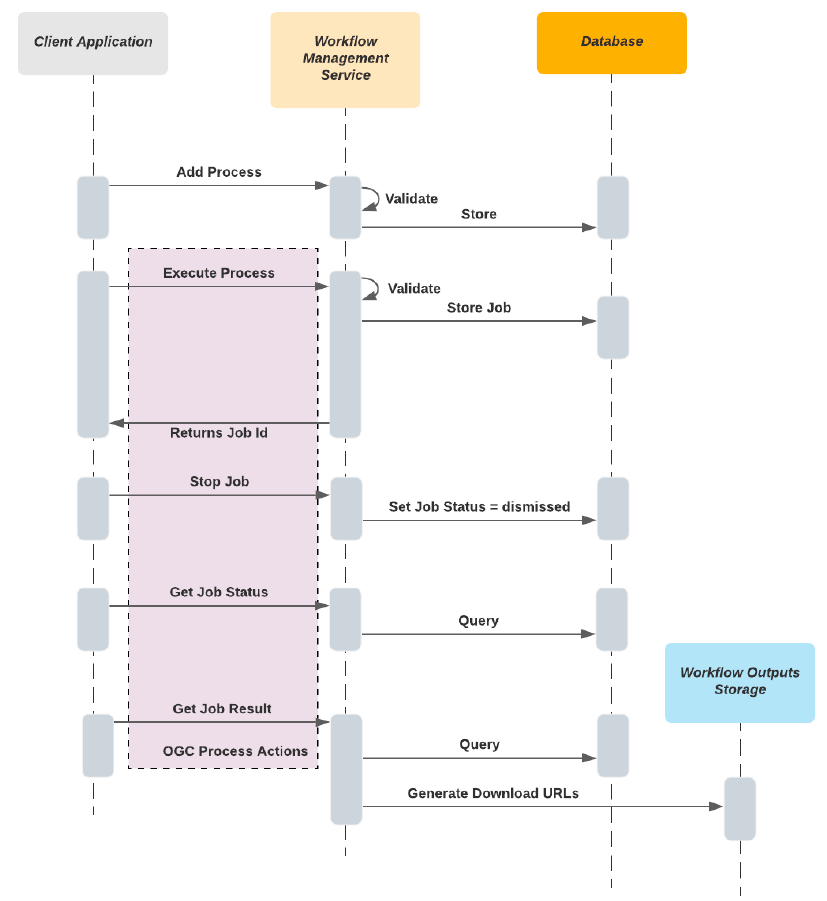
Figure 7. Workflow management service sequence flows for each type of request.